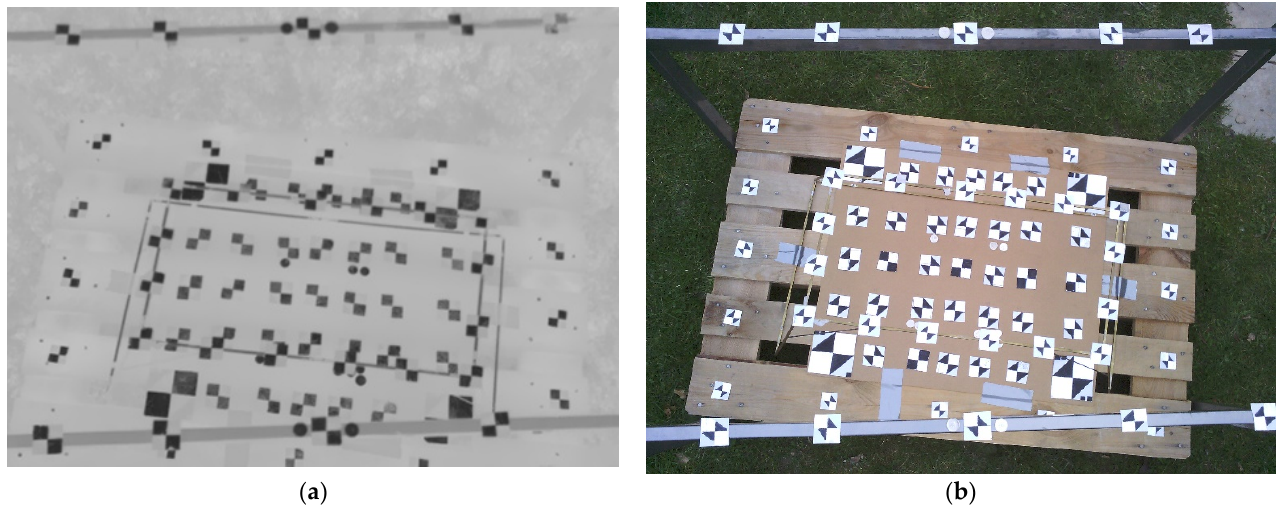
Figure 8. Images for camera calibration using the 3-level calibration field: ( a ) TIR image ( b ) RGB image. As a third calibration field, a plane calibration field was created, see Figure 9. In [18], the authors showed that, by using circular targets, it is possible to achieve better results compared to the chessboard plane calibration field. The plane calibration field was created professionally by the manufacturer. The manufacturer advised using stainless steel to have the highest possibility of a firm (not banded) plane field. The calibration field was a 350 × 350 mm desk, 1 mm thick, from stainless steel; in the desk, there were cut-out circles with a diameter of 15 mm. The circles were cut out with a 0.1 mm tolerance of position. The dimensions of the circles were chosen to have enough pixels in the TIR images, if imaging was from a 30 cm distance for the ellipse operator or gravity operator function. The desk was placed on a flat wooden desk. The main idea behind cut-out circles from the calibration field was to have the same effect that we had with cross aluminum paper tar- gets. Stainless steel is a material with low emissivity and the desk was placed on a wooden flat desk, so the holes had high emissivity; then, it was possible to detect the circles on TIR images.